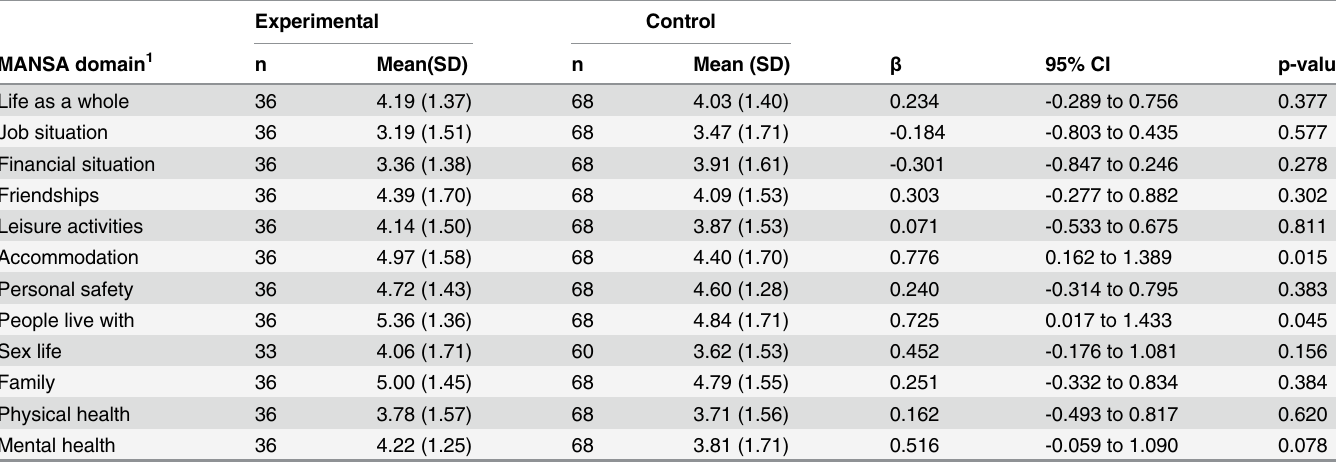
Table 3. Mixed effects linear regression for MANSA items at 12